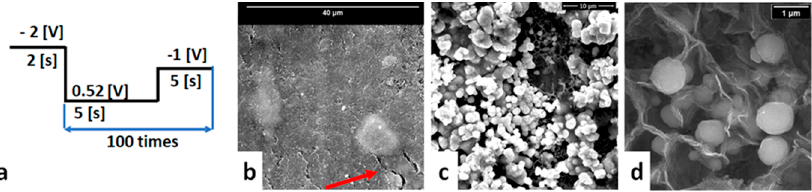
Figure 6. Copper electrodeposition on CNW without thermal treatment: ( a ) schematic representation of applied pulses; ( b – d ) corresponding SEM images.